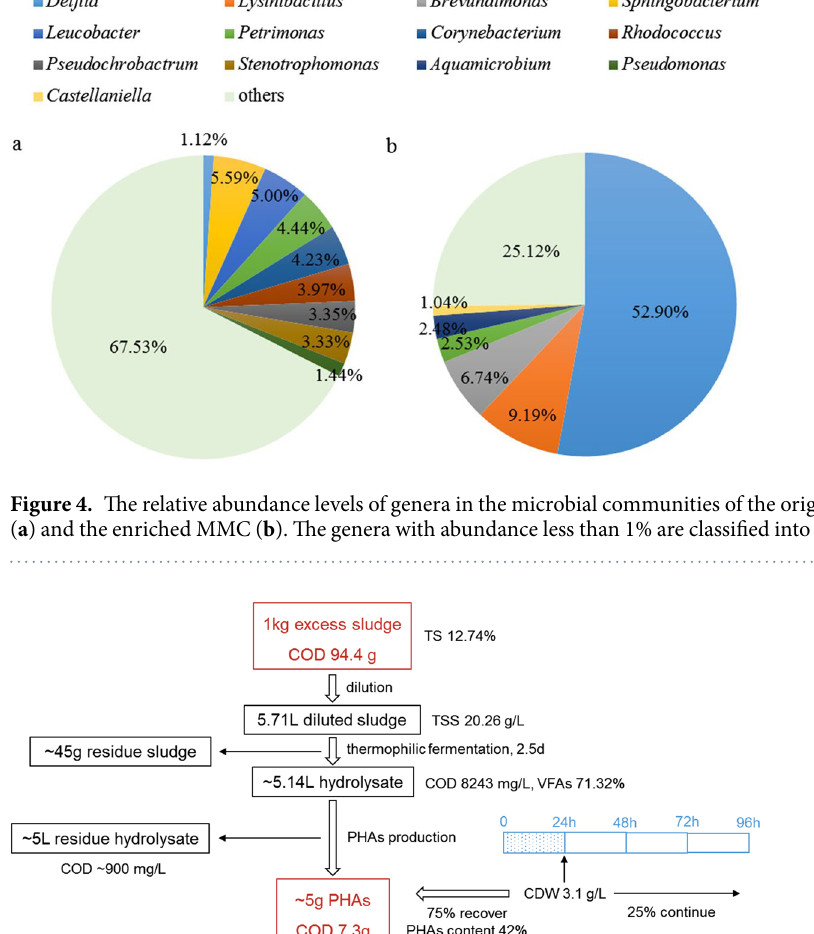
ordinary cultures enriched by acetate-dominant or butyrate-dominant hydrolysates. The valerate-preferred MMC could better confront complex components and resist the latent inhibition of non-VFAs and nutrients. Based on the microbial analysis, the enriched MMC revealed particular characteristics of community com- position, and Delftia was first observed to exceed 50% percentage in the PHA enrichment. This might be because Delftia had a close affinity with valerate. It was reported that the pure culture of Delftia acidovorans displayed rapid valerate uptake and formed PHBV containing up to 90 mol% 3HV 13 . Despite the fact that the microbial community was also related to the origin of activated sludge and the operating conditions of the reactor 11 , Delftia prevailed over other typical PHA-producing bacteria in the MMC, such as Lysinibacillus and Brevundimonas (Fig. 4), which were observed to be dominant groups in the PHA enrichments 35 . This behavior demonstrated that Delftia had better adaptability to valerate-dominant environment than did other PHA-producing bacteria. New insights were gained concerning specific VFA uptake. For the first time, it was elucidated that the uptake rate of the odd-carbon VFA valerate was higher than that of the even-carbon VFAs acetate and butyrate, high- lighting the flexibility of VFAs uptake. This provided evidence that the VFAs consumption sequence and extent were closely linked to the substrate for enrichment. The concentrations and percentages of different VFAs in the enrichment feedstock shaped the microbial composition of the enriched culture, as well as the PHA synthetic pathway 10 . Thereupon, the microbial composition directly affected the utilization of individual VFA, as different PHA-producing bacteria had specific VFA-uptake preferences 11 . When valerate exhibited absolute dominance compared to even-carbon VFAs in the enrichment substrate, the enriched MMC involved prevailing Delftia , rein- forcing valerate consumption. Hence, the valerate-dominant hydrolysate played an important role in the selective utilization of VFAs by the MMC when used as the enriching substrate. In addition, the dynamic changes of the uptake rates regarding different VFAs (Fig. 1c) indicated that the VFAs utilization was concentration dependent. The optimal range of combined N and P for PHA production was proposed as N/COD 2-15 mg/g and P/COD 0.5–3 mg/g, which could offer a consistent improvement of PHA productivity 26 . In this study, N/COD and P/COD in the valerate-dominant sludge hydrolysate were 57.66 and 5.56 mg/g, respectively. In addition to the original N